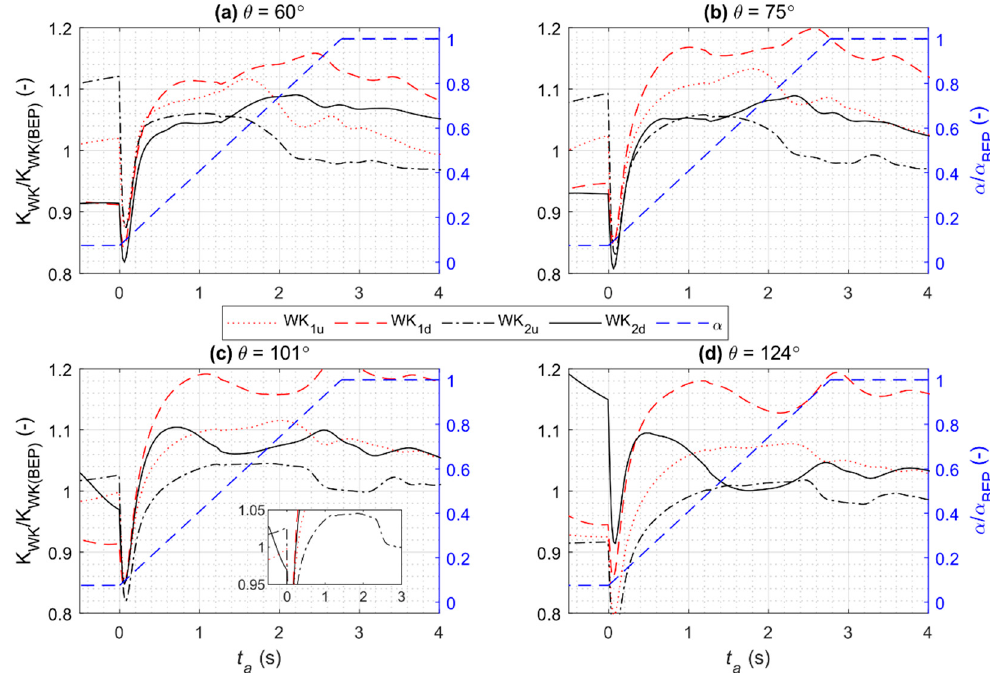
Figure 11. Variation of the WK coefficients over time during acceleration at four different azimuthal locations of the SC. The WK coefficients were calculated from Equation (1) with n = 0.5. The coefficients after the transient time, i.e., when t a > 2.77s s do not coincide with the value of 1 because the flow takes some time after the transient to stabilize and be steady.